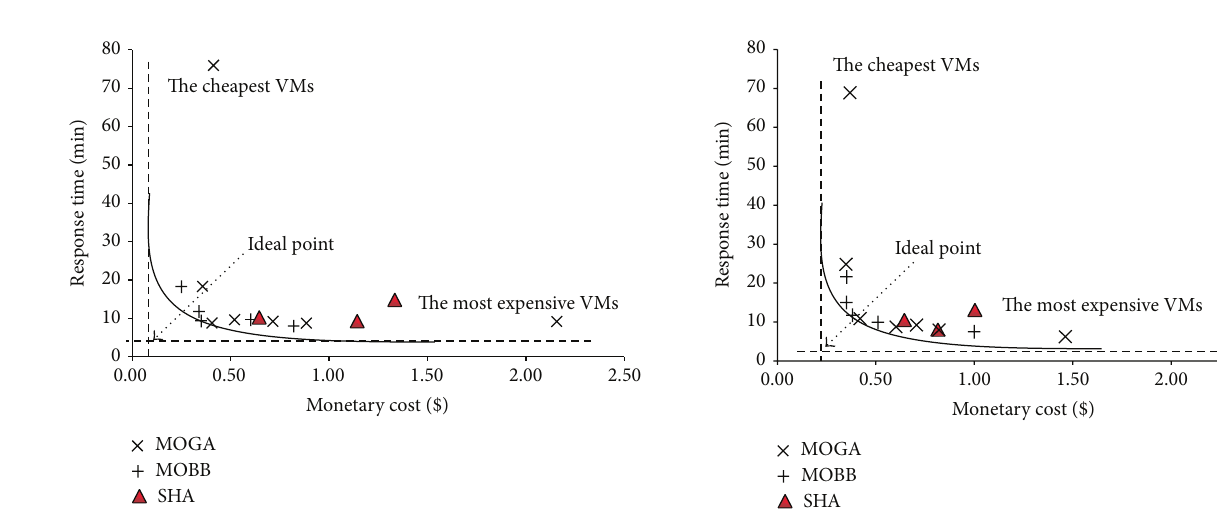
Figure 16: Proposed paretooptimal solutions for workload 2 by SHA, MOBB, and MOGA